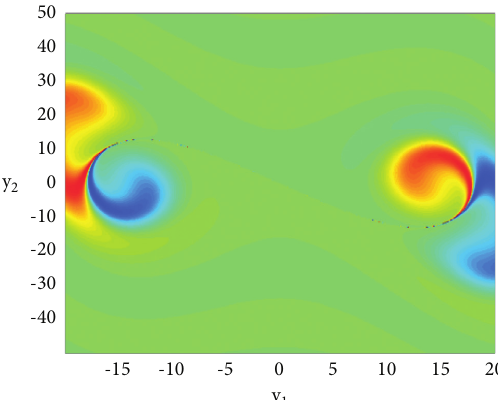
Figure 11: View of Matouk’s system (4) in y (green plot), one-point attractor corresponding to Eq ( 2 ) � ( 2 . 5981 , 10 . 1 , 15 , 0 ) (red plot), and one-point attractor corresponding to Eq ( 3 ) � (− 2 . 5981 , − 10 . 1 , 15 , 0 ) (blue plot).